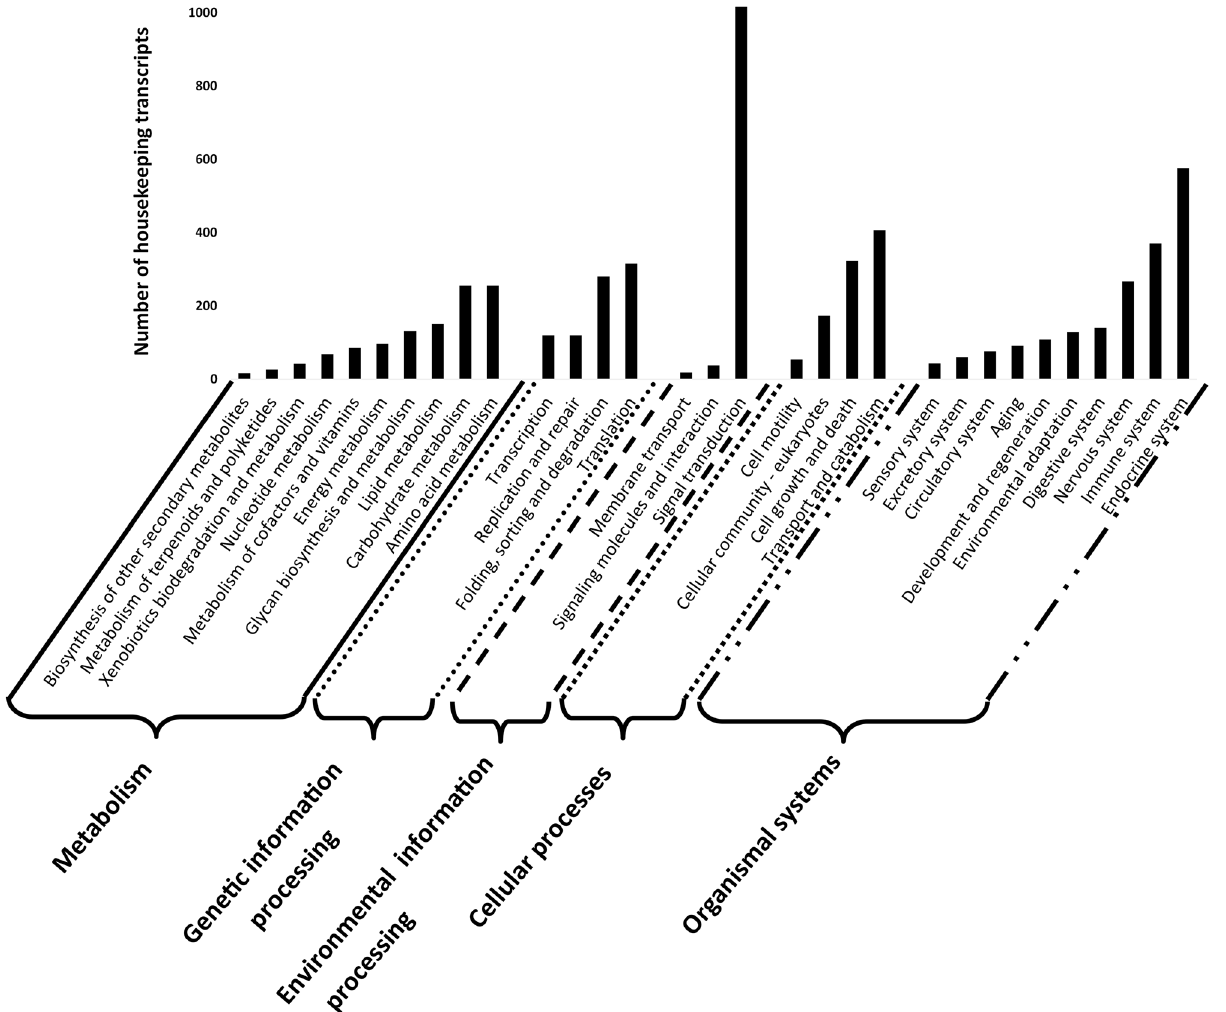
Figure 3. Housekeeping proteins from Rhipicephalus evertsi evertsi that mapped to the five groups of known housekeeping pathways defined by Kegg